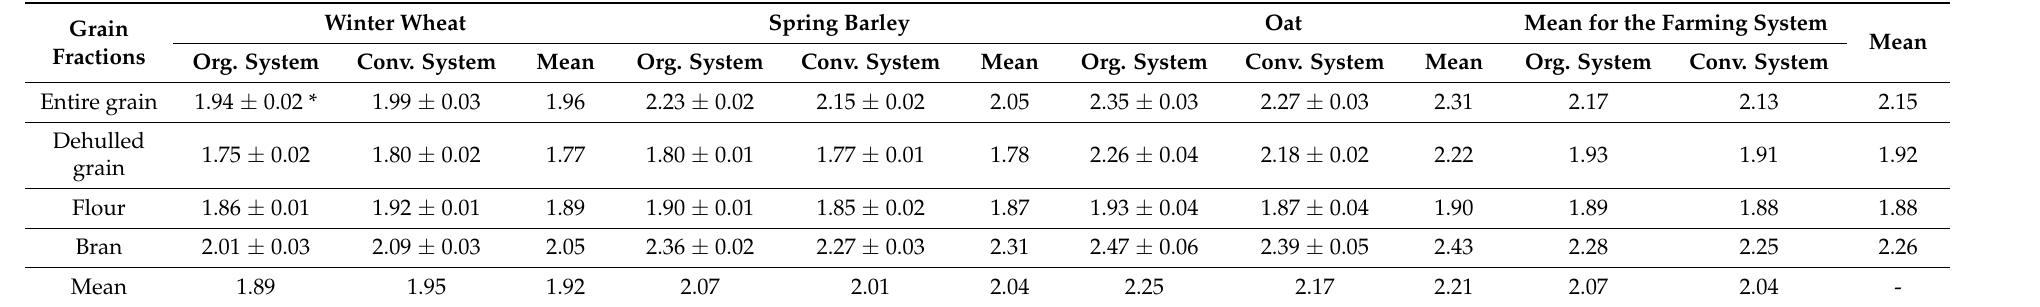
Table 1. Effect of cereal grain milling on total polyphenol content (mg g − 1 DM of catechin)—2017–2019 average.